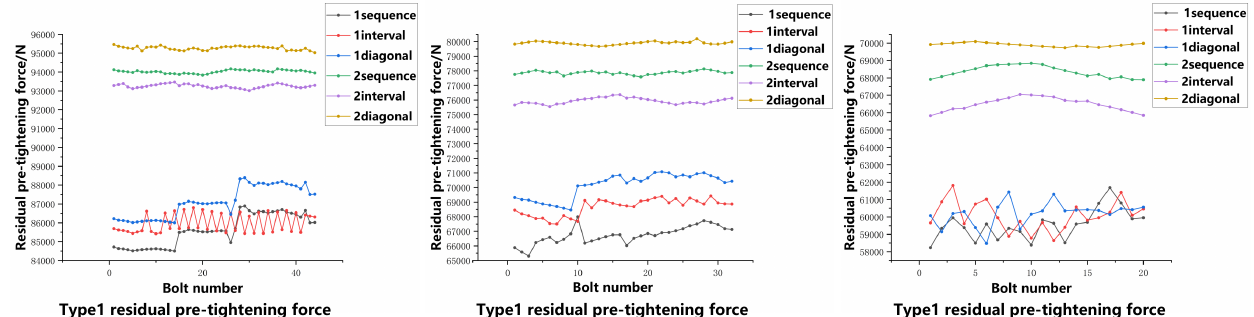
Figure 21. Bolt residual pre-tightening